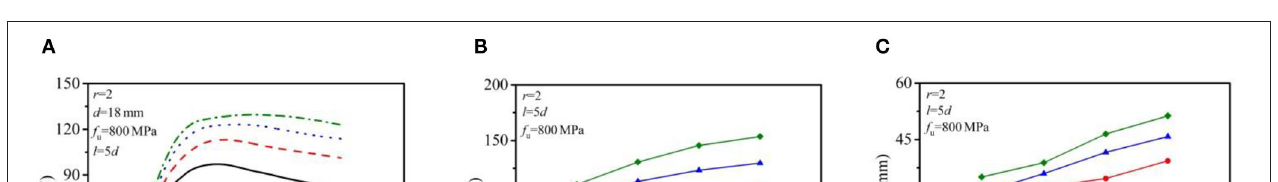
FIGURE 10 | Analyzed ultimate deformation of 18mm multi-bolt connectors.